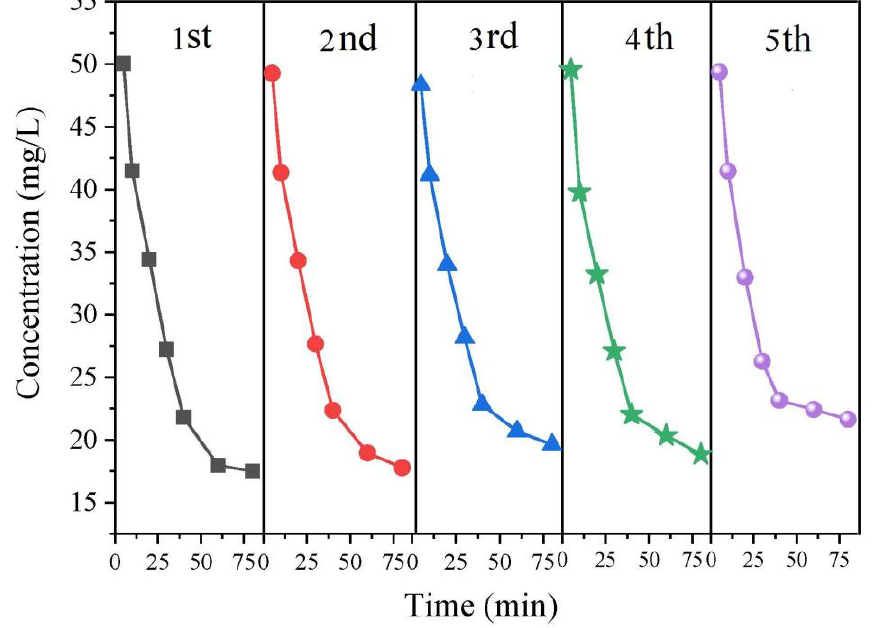
Figure 8. Reusability of PbO 2 -NF electrode.